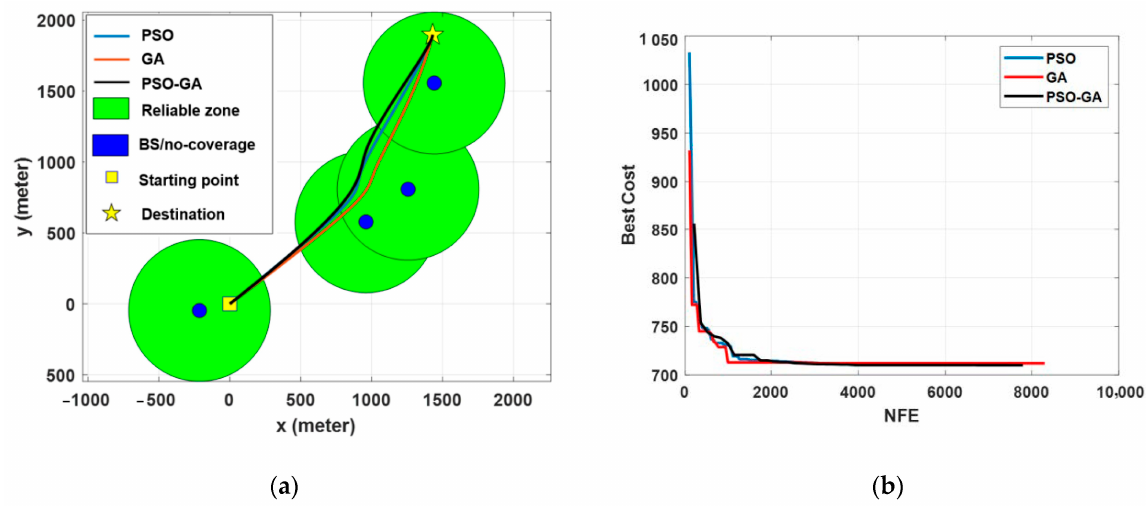
Figure 8. Simulation results of different optimization algorithms in Scenario I: ( a ) path planning results and ( b ) cost function value vs. the number of function